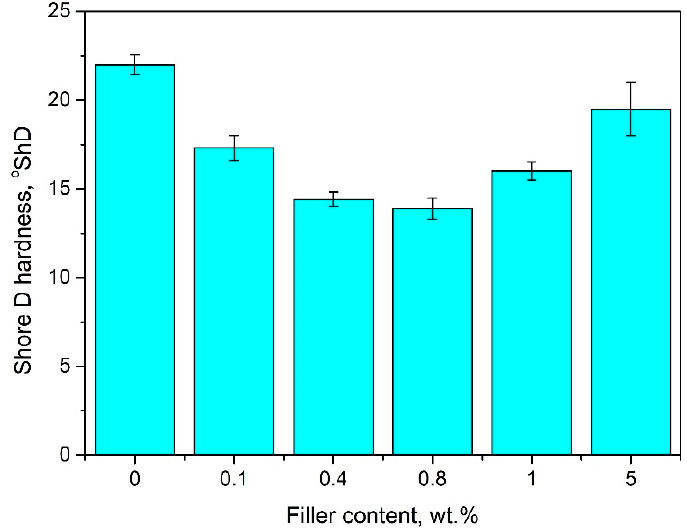
Figure 10. Shore D hardness of pure PE-wax filled with various amounts of bentonite.